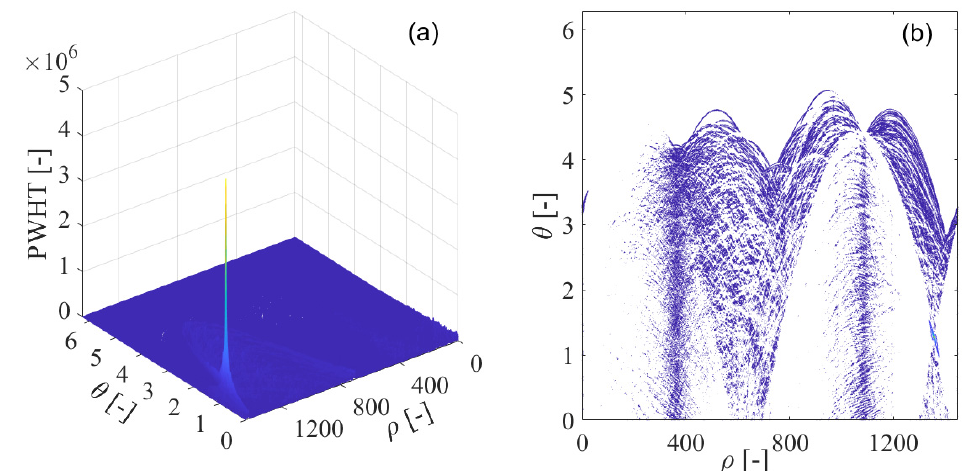
Figure 13. The pseudo-Wigner–Hough transform (PWHT) of GPS L1-C/A signal disturbed by the sweep interference. ( a ) PWHT; ( b ) PWHT’s contour.